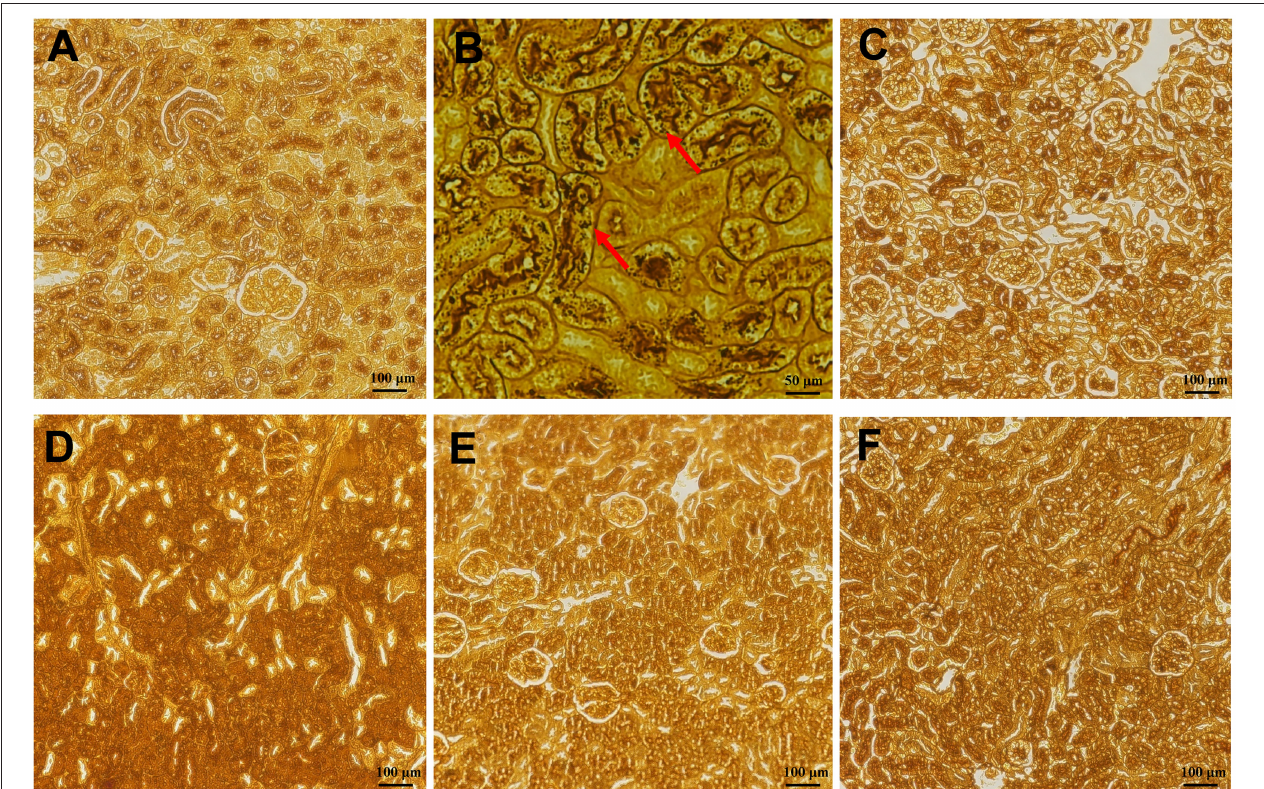
FIGURE 8 | Histopathology of the kidneys. (A) Represented the kidneys of normal mice without infection. PASM-stained images are shownfor the infected mice with water (B) , or 1.5 mg/kg/d of FLC (C) , and the different dosages of SAN [ (D) , 0.5 mg/kg/d; (E) , 1.5 mg/kg/d; (F) , 2.5 mg/kg/d], magnifications, × 200. Black staining (red arrows) reflects areas of numerous intracellular and extracellular C. albicans cells [ (B) , × 400].